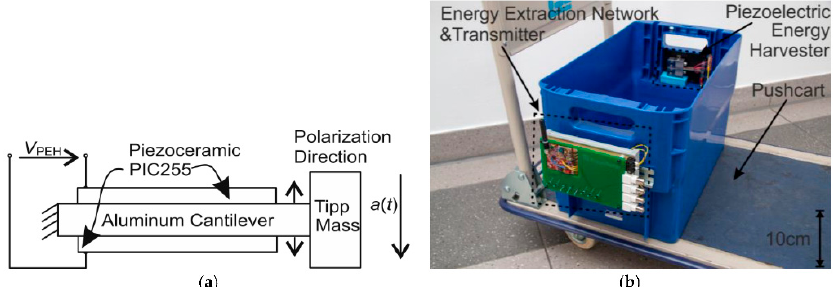
Figure 1. ( a ) Piezoelectric energy harvester. ( b ) Photography of pushcart with container, piezoelectric energy harvester and energy extraction